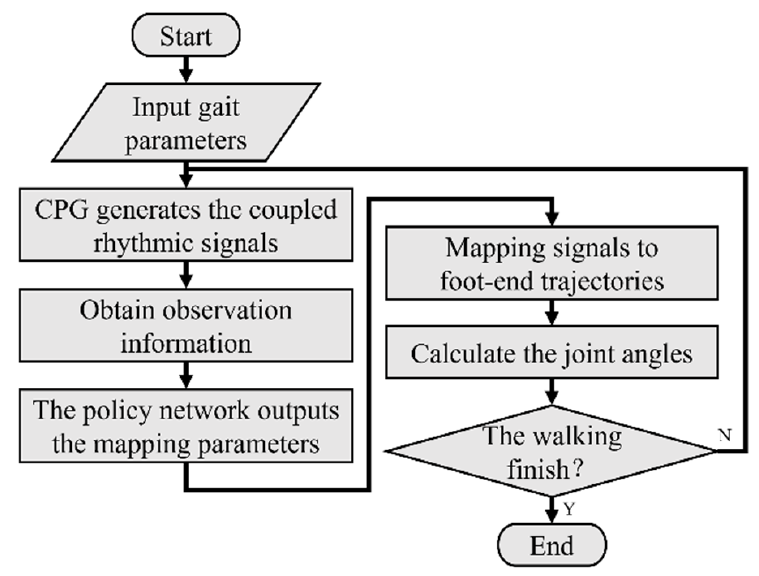
Figure 6. Flowchart of the robot walking with the RL-CPG algorithm.